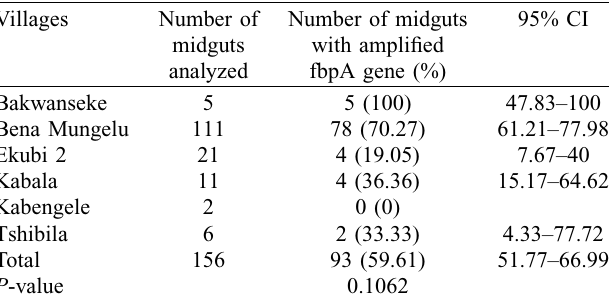
Table 4. Ampli fi cation rates of the fbpA gene according to the